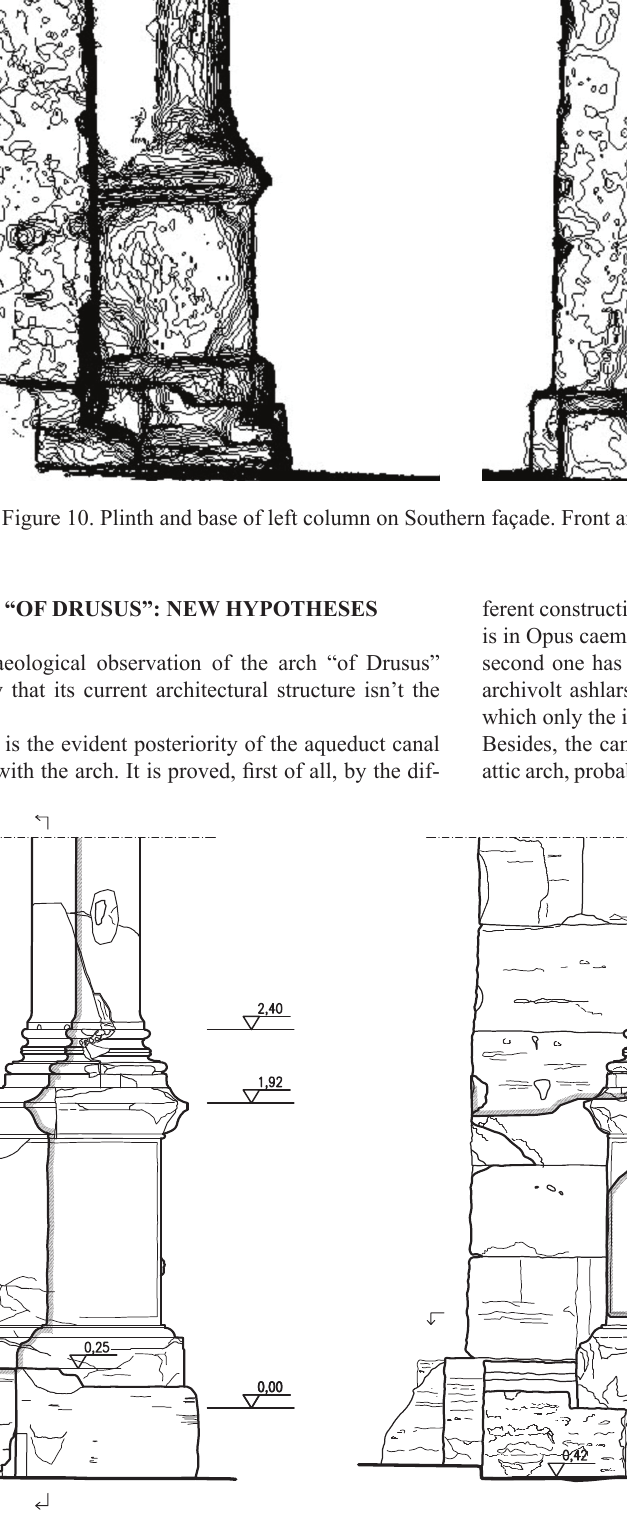
Figure 11. Plinth and base of left column on Southern façade. Front and Western side with sections in